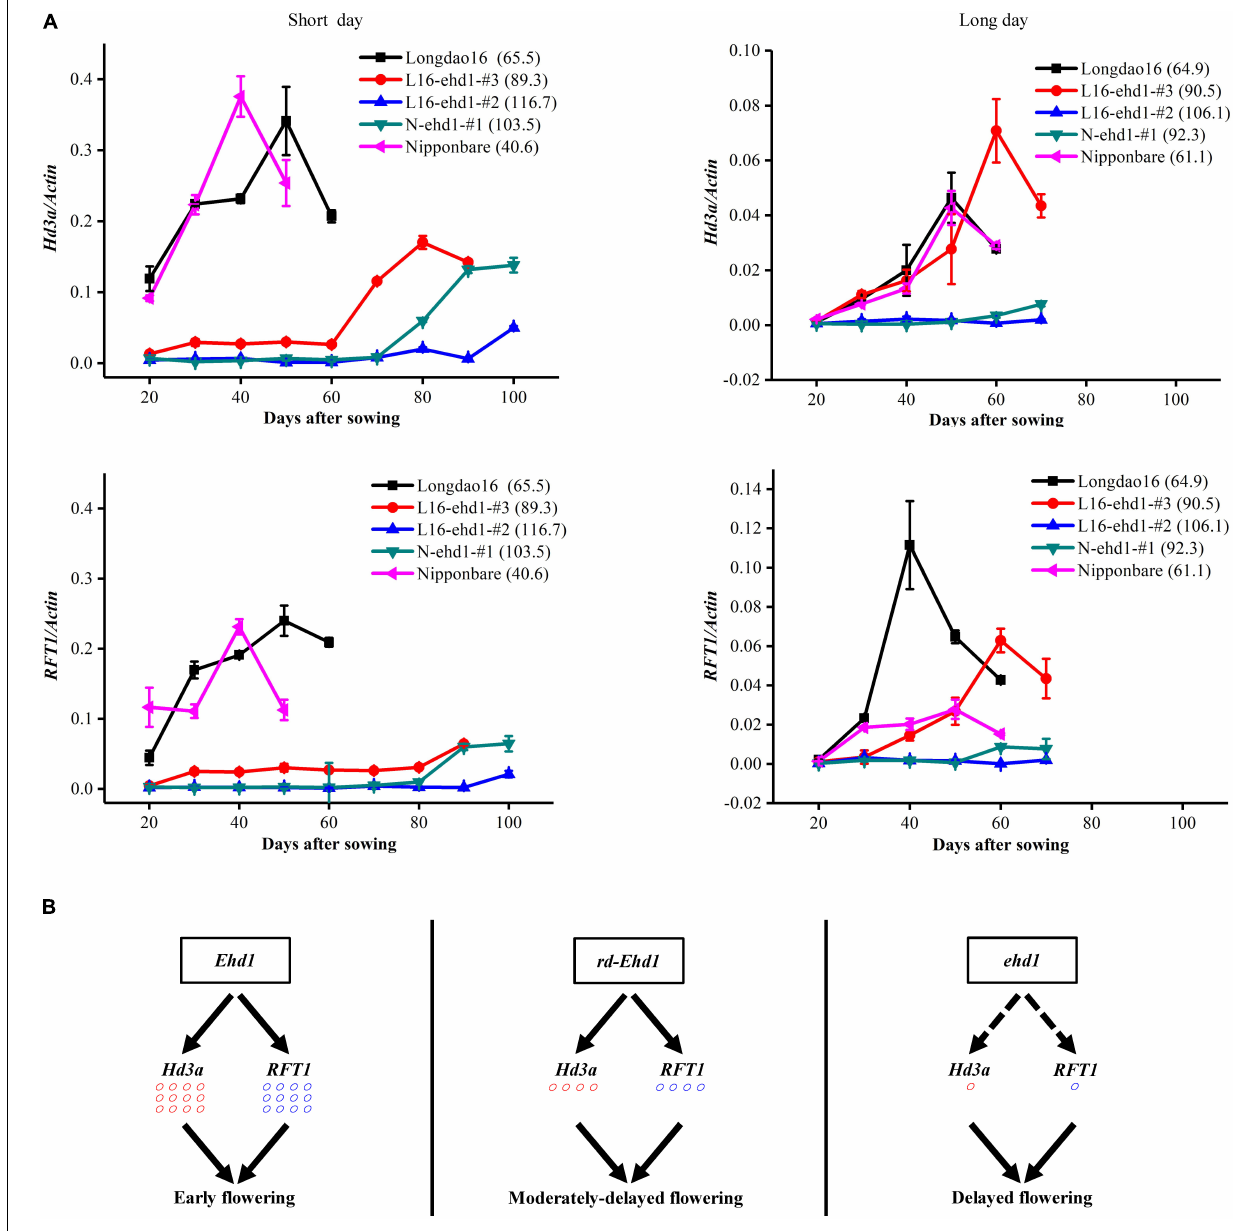
FIGURE 4 | Minor in-frame deletion in the receiver domain partially impairs the function of Ehd1 on activation of Hd3a and RFT1 . (A) Expression patterns of Hd3a and RFT1 in frame-shift mutant lines N-ehd1-#1 and L16-end1-#2, and in-frame mutant line L16-end1-#3. T 2 homozygous lines were used for detection. Fully expanded leaves were sampled 2 h after dawn every 10 days (the first time to harvest samples was 20 days after sowing). Three different rice plants were used as biological replicates and the experiments were repeated three times with similar results. Gene expression values are shown as mean and standard deviation of the three biological replicates. Days to heading of each line are shown in parentheses. (B) Schematic model of the minor deletion -ehd1 - Hd3a / RFT1 regulatory network. Functional Ehd1 promotes the expression of two florigen genes Hd3a and RFT1 (left panel). In ehd1 background, the expression of Hd3a and RFT1 was inhibited (right panel). In-frame deletion ehd1 partially activates the expression of Hd3a and RFT1 (middle panel), resulting in a moderately-delayed flowering phenotype. rd-Ehd1 represents in-frame deletion ehd1 alleles.